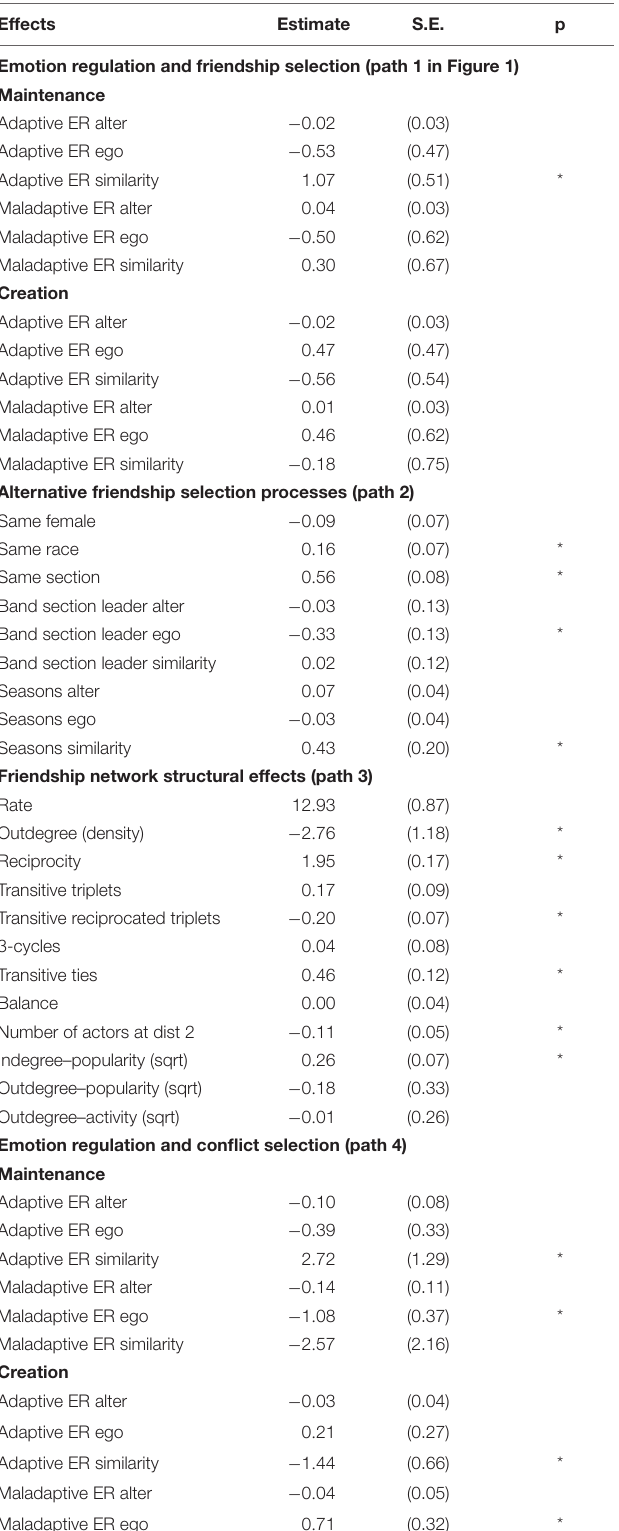
TABLE 2 | Stochastic actor based model results for contributions of emotion regulation to selection in friendship and conflict networks.